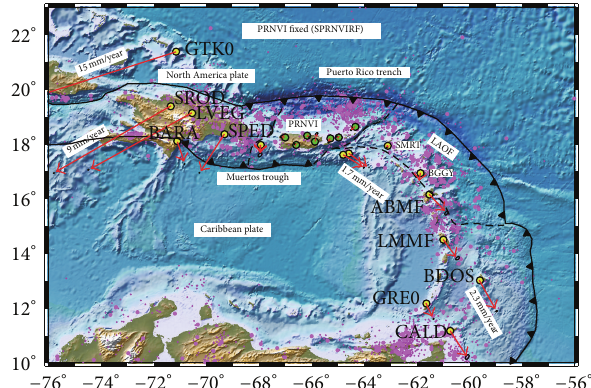
Figure 7: Velocity vectors of permanent GPS stations ( > 5 years) within the PRVI and Lesser Antilles region. The vectors are referred to the SPRNVIRF. The boundary between the Lesser Antilles inner forearc and outer forearc is plotted with a dark dashed line. The small pink dots represent earthquakes (1900–2014) with magnitudes between 4 and 5 ( 4.0 ≤ 𝑀 < 5.0 ); the big pink dots represent earthquakes (1900–2014) with magnitudes larger than 5.0 ( 𝑀 ≥ 5.0 ). Earthquake epicenter and magnitude information is obtained from the U.S. Geological Survey Advanced National Seismic System (ANSS) Comprehensive Catalog